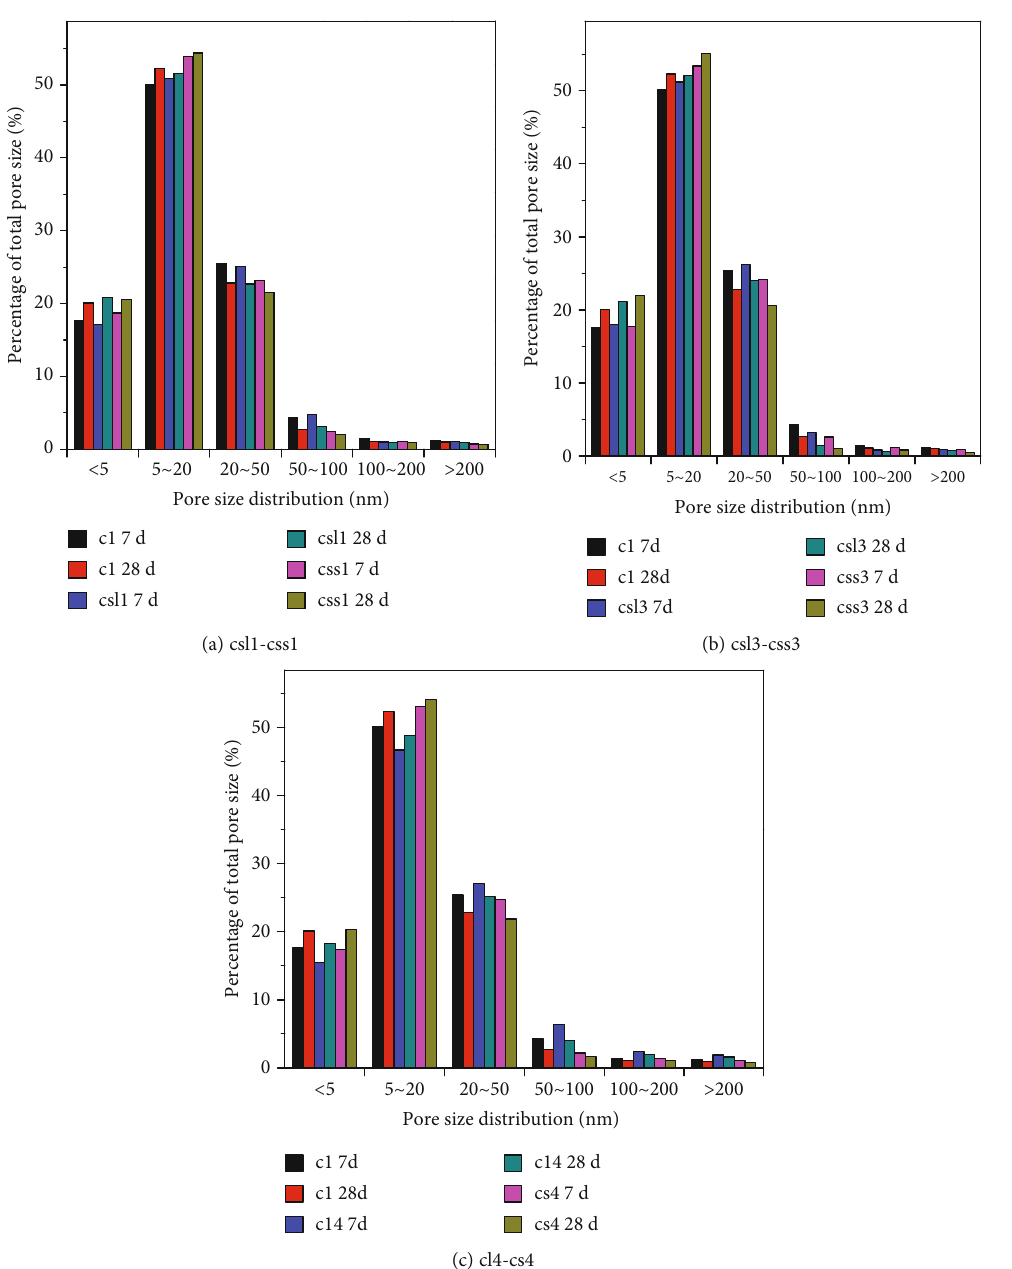
Figure 9: Comparison of pore size